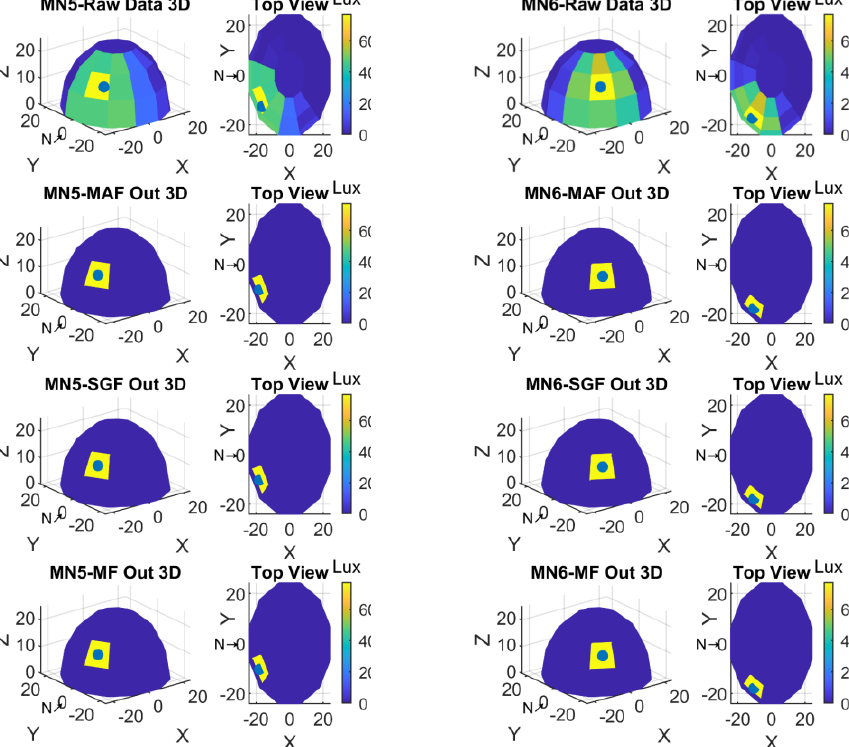
Figure 14 . Spherical and top view of MN5 and MN6 experiment result. Figure 14. Spherical and top view of MN5 and MN6 experiment